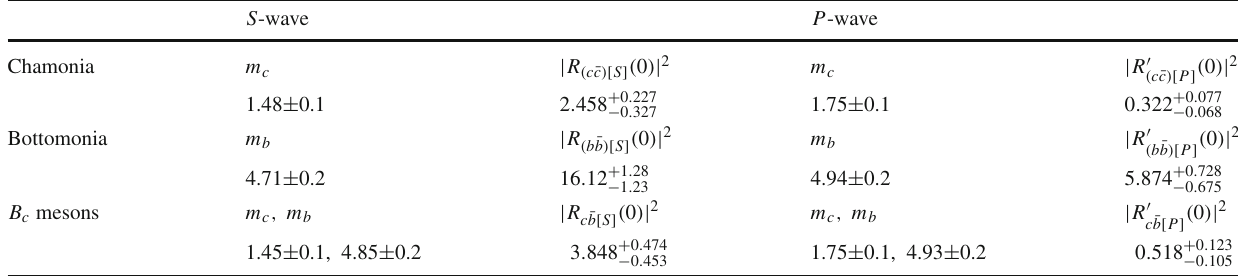
Table 1 The masses (units: GeV) of the constituent quarks, and the monia, bottomonia and B c mesons within the BT-potential model [62]. The uncertainties of radial wave functions (or their first derivatives) at squared radial wave functions at the origin | R S ( 0 ) | 2 (units: GeV 3 ) and ( 0 ) | 2 (units: GeV 5 ) for the char- their first derivatives at the origin | R (cid:5) P